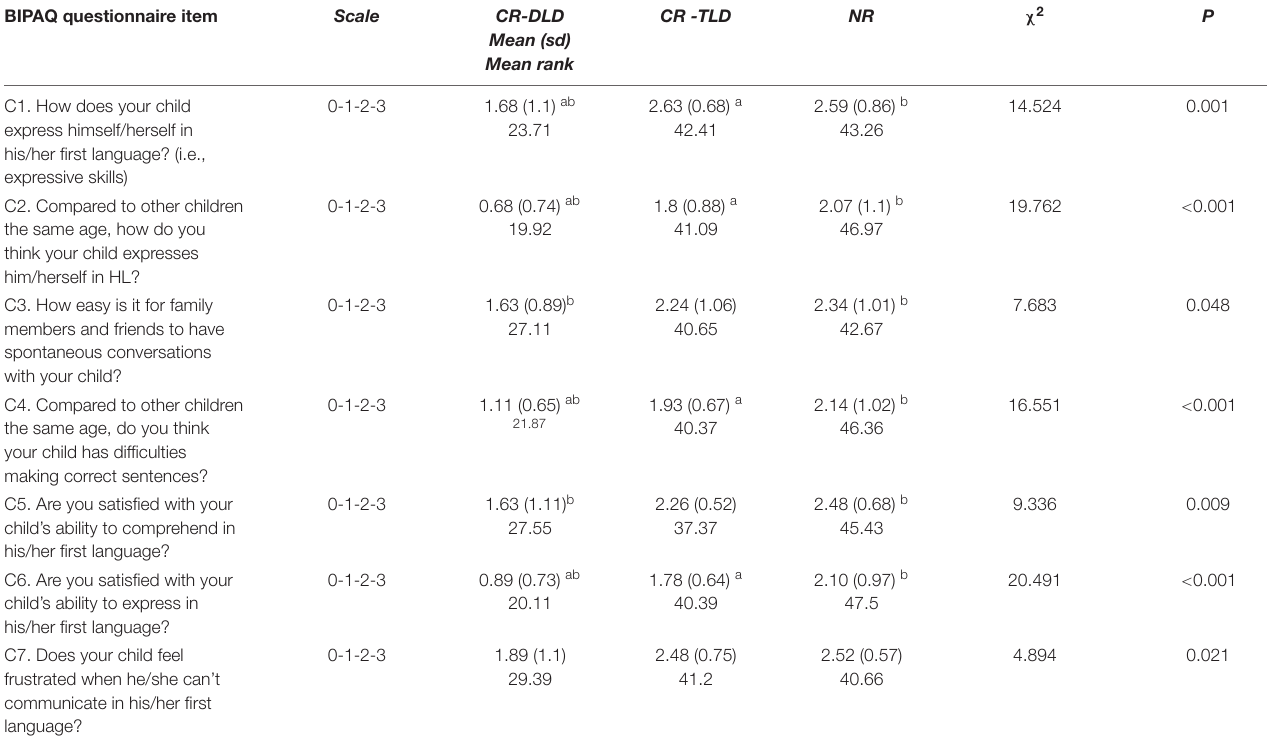
TABLE 4 | Questions Section C: HL Language